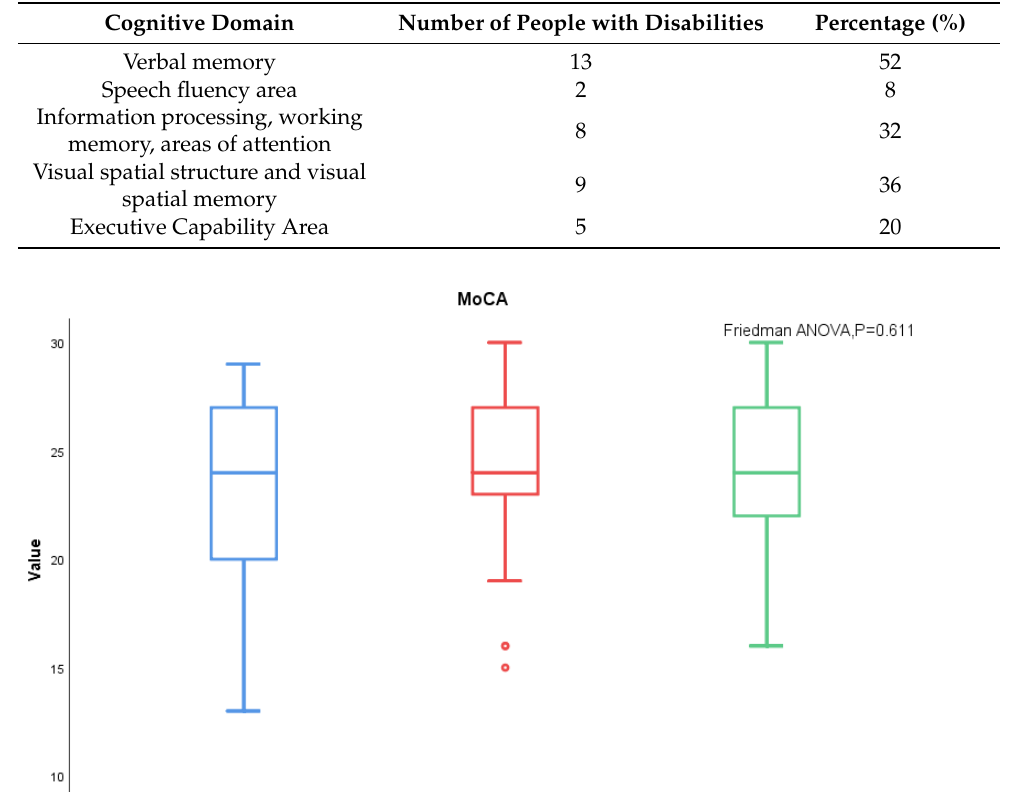
Figure 3. AQP-4 antibody titers between acute and chronic NMOSD.